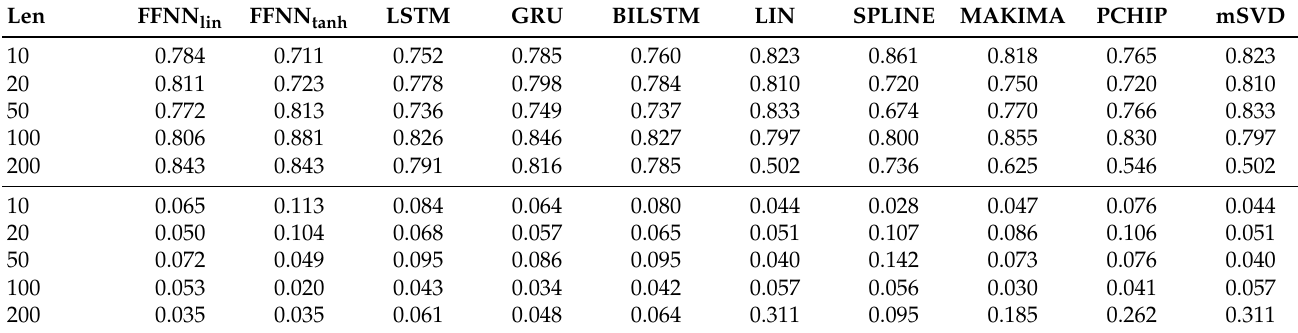
Table A10. Correlation between RMSE and jerk of input